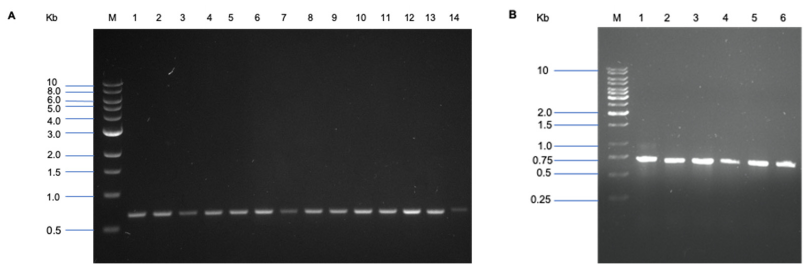
Figure 1. Species-specific PCR amplification with primers 15F and 687R. ( A ) Lane M: (1 Kb ladder), Lane 1: ( Lactobacillus reuteri Protectis DSM17938), and Lanes 2–14: (isolates L1–L13). ( B ) Lane M: (1 Kb